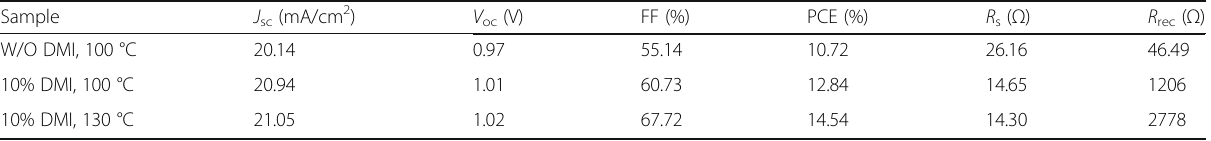
Table 1 Photovoltaic parameters of the best PSCs fabricated from three different conditions